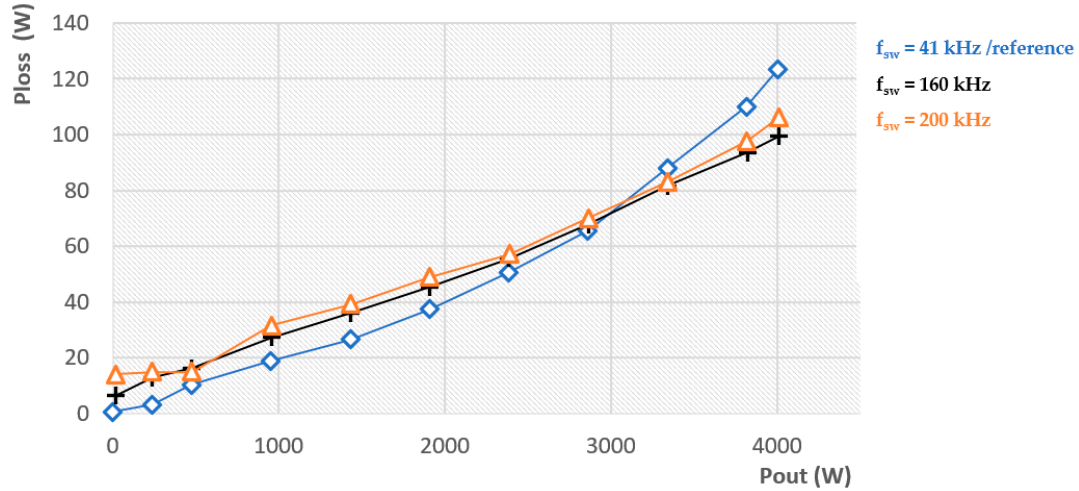
Figure 12. Power losses of PFC converter equipped with TP65H050WS GaN transistor in dependency on the output power and switching frequency (blue line—referenced non-optimized solution).